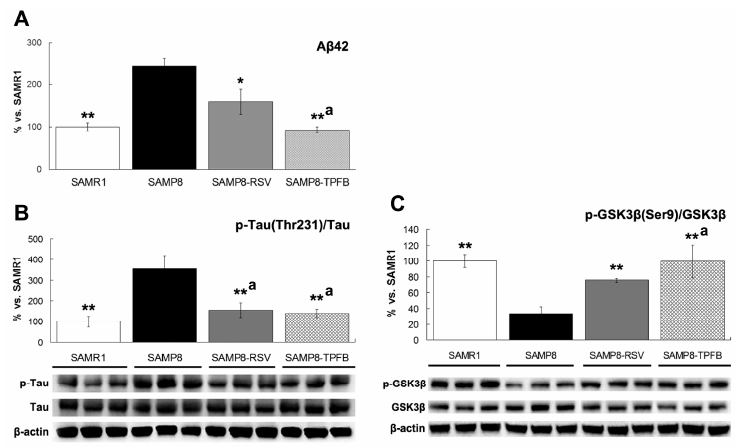
Figure 3. TPFB significantly decreased protein levels of A β 42 and Thr231-phosphorylated Tau, and increased Ser9-phosphorylated glycogen synthase kinase 3 β (GSK-3 β ) in SAMP8 mice brains.